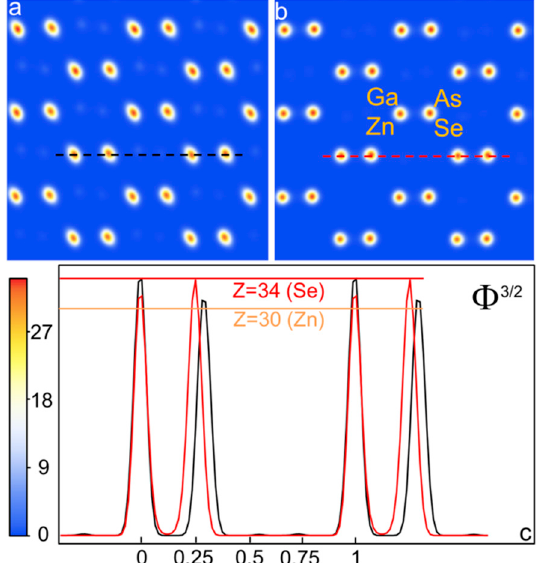
Figure 6. Deconvolution of the GaAs/Znse [110]-projected atomic potential auto-correlation function C( r ): ( a ) projected atomic potential obtained from raw experimental nano-diffraction data; ( b ) projected atomic potential obtained from rescaled nano-diffraction data; ( c ) scans of the averaged projected atomic potentials, elevated to the power of 3/2 for a direct comparison with the atomic number Z, in red for the restored intensities, in black for the raw data.